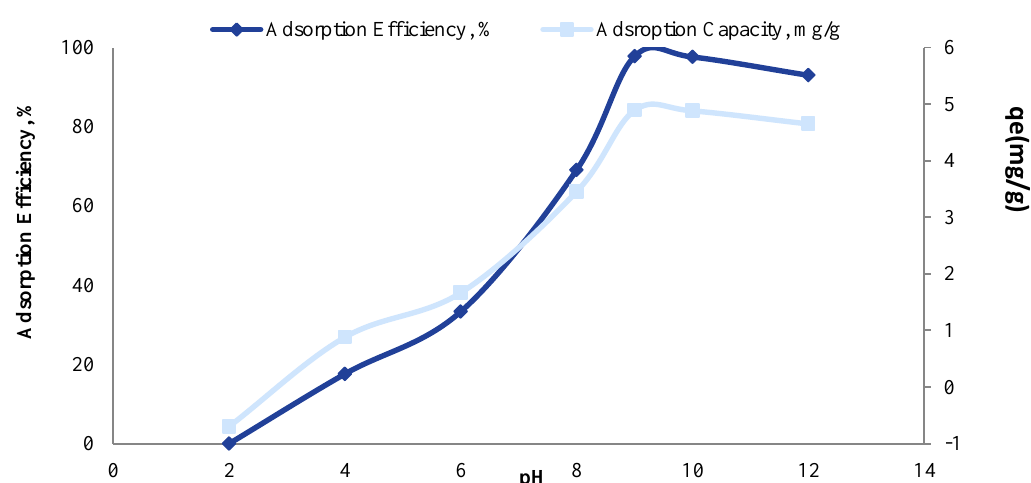
Figure 5. Comparison of the effect of pH changes on removal efficiency of copper using MCh/Fe-Zr nanoparticles